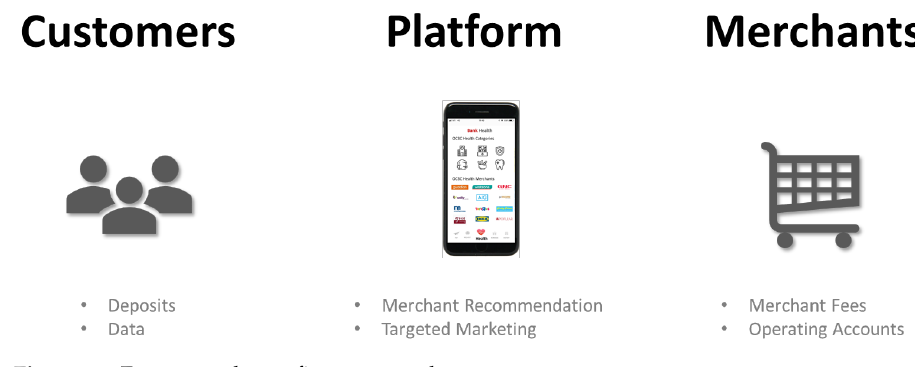
Figure 18. Future product refinement works.